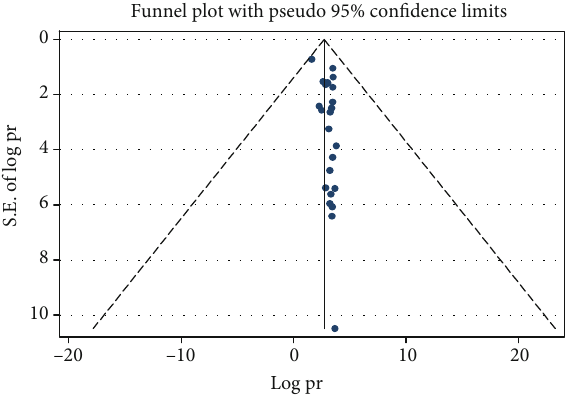
Figure 6: Funnel plot to test the publication bias in 24 studies of anxiety with 95% con fi dence limits.